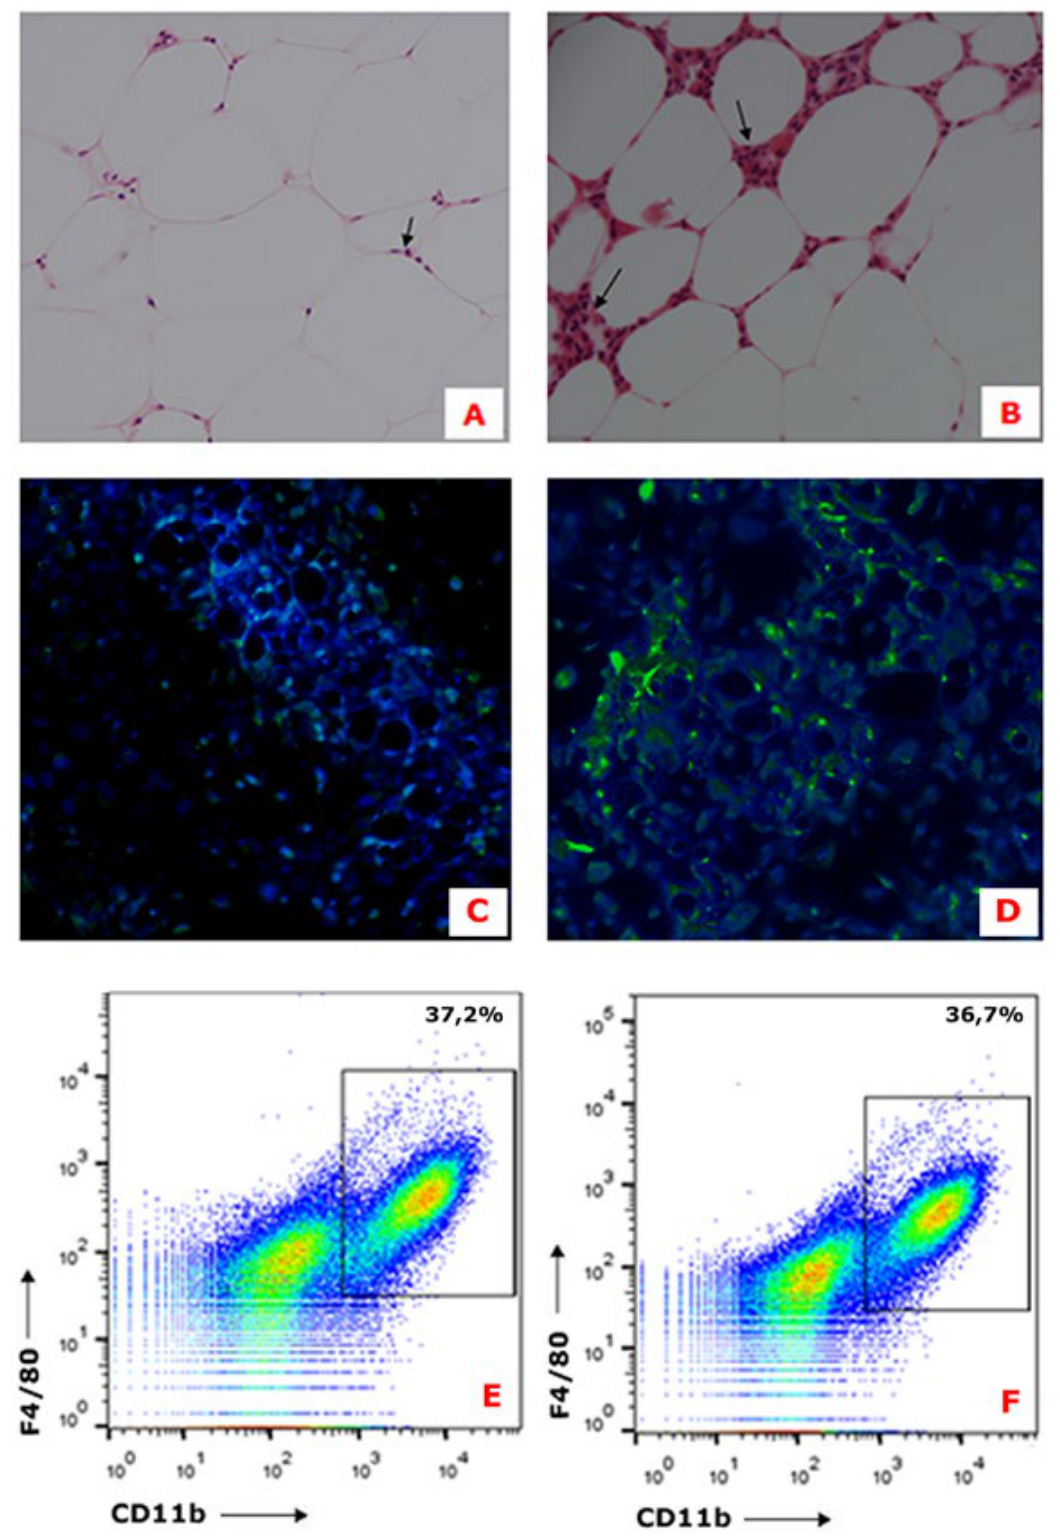
FIGURE 1 – Photomicrograph of representative histological sections of epididymal fat pad stained with hematoxylin-eosin. Control (A) and high-fat (B) animals show cellular infiltrate between the adipocytes, as indicated by the arrows (200x). Immunohistochemistry of adipose tissue showing macrophage infiltrate in Control (C) and High-fat (D). Immunophenotyping of macrophages populations in the peritoneal population by flow cytometry in Control (E) and High-fat